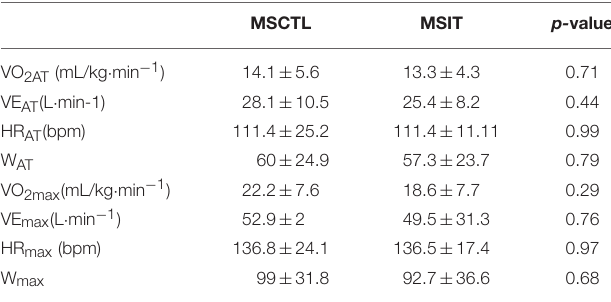
TABLE 1 | Data from the cardiopulmonary test gathered at T0 in the control Multiple Sclerosis group (MSCTL, n = 10) and in the intervention Multiple Sclerosis group (MSIT, n = 11)